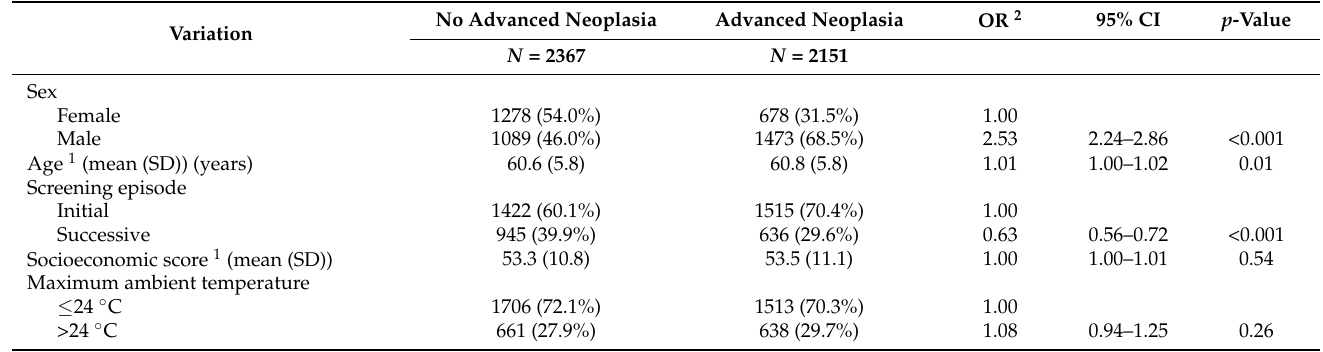
Table 4. Logistic regression of advanced neoplasia (screen-detected CRCs, high-risk and intermediate- risk